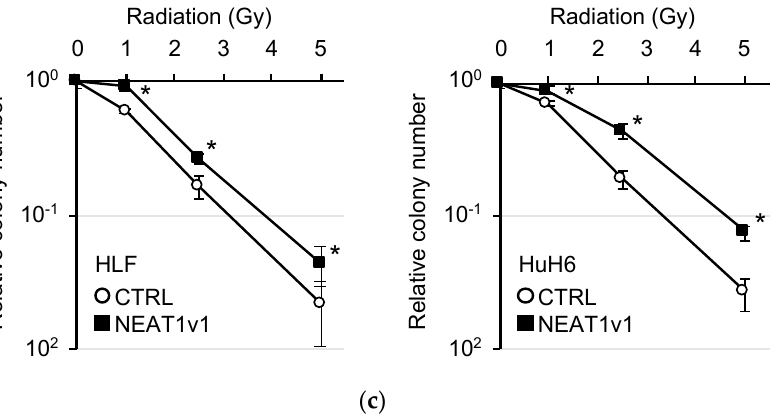
Figure 4. Promotion of autophagy and radioresistance by NEAT1v1 overexpression. ( a ) Expression levels of total NEAT1 , NEAT1v2 , and GABARAP mRNA in HLF and HuH6 cells stably transfected with NEAT1v1 (V1) or empty vectors (C). * p < 0.05 vs. C; Students’ t -test ( n = 4). ( b ) LC3 and GABARAP protein expression in NEAT1v1 -expressing HLF and HuH6 cells treated with DMSO or 50 nM bafilomycin A1(BafA) for 24 h. ( c ) Clonogenicity of HLF (left) and HuH6 (right) cells after X-ray irradiation. Cells were stably transfected with NEAT1v1 (closed rectangles) or empty (CTRL; open circles) vectors. * p < 0.05 vs. CTRL; Students’ t -test ( n = 3). ( d ) LC3 and GABARAP protein expression in NEAT1v1 -expressing HLF and HuH6 cells 48 h after 5-Gy